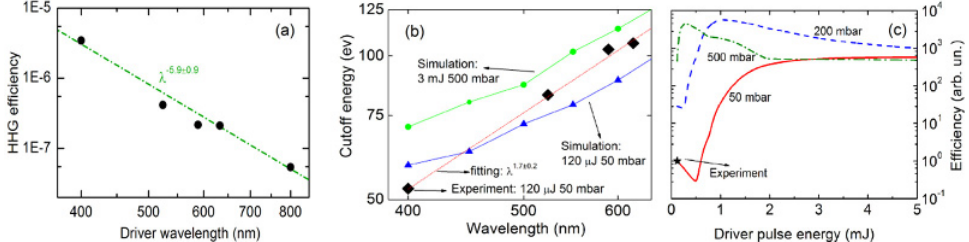
Fig. 2. (a) efficiency scaling in argon; (b) cut-off energy scaling in helium, experimental points and simulations; (c) calculated HHG efficiencies in helium at higher driving energies than the experiments.